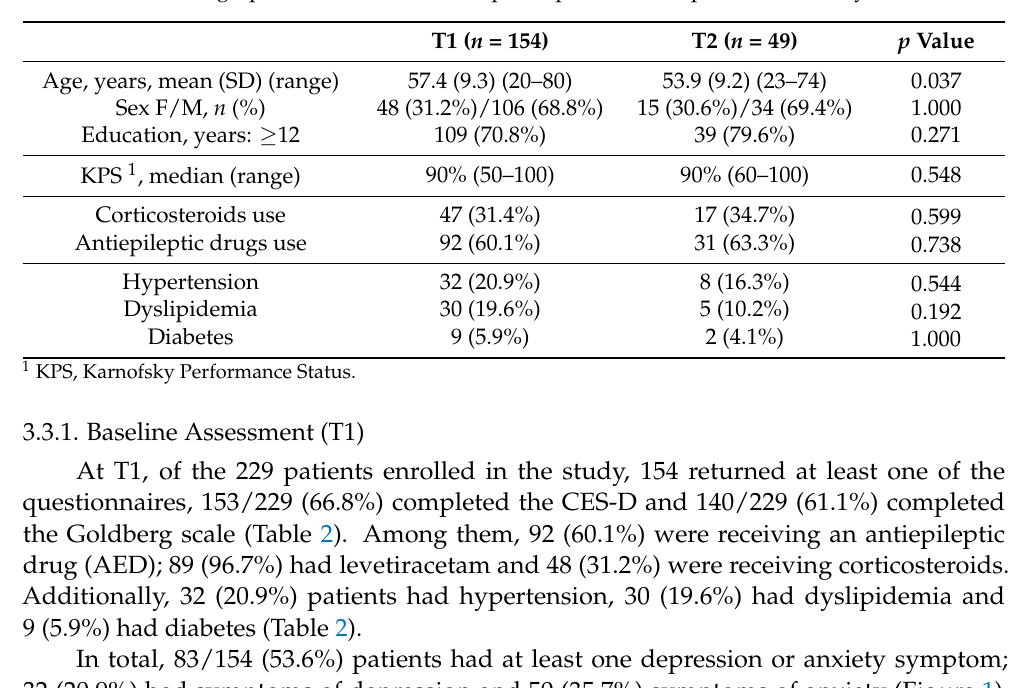
Table 2. Sociodemographic and clinical data of participants in the EpiBrainRad study.